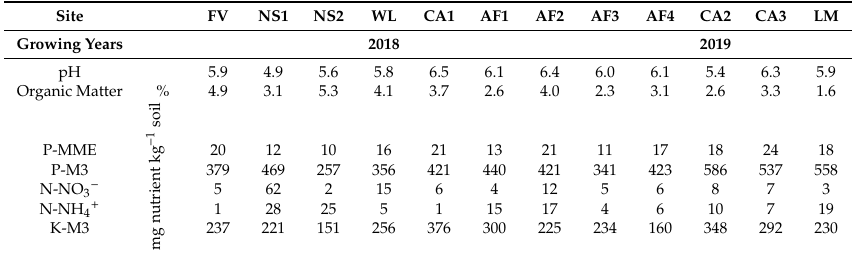
Table 2. Relevant soil analysis of